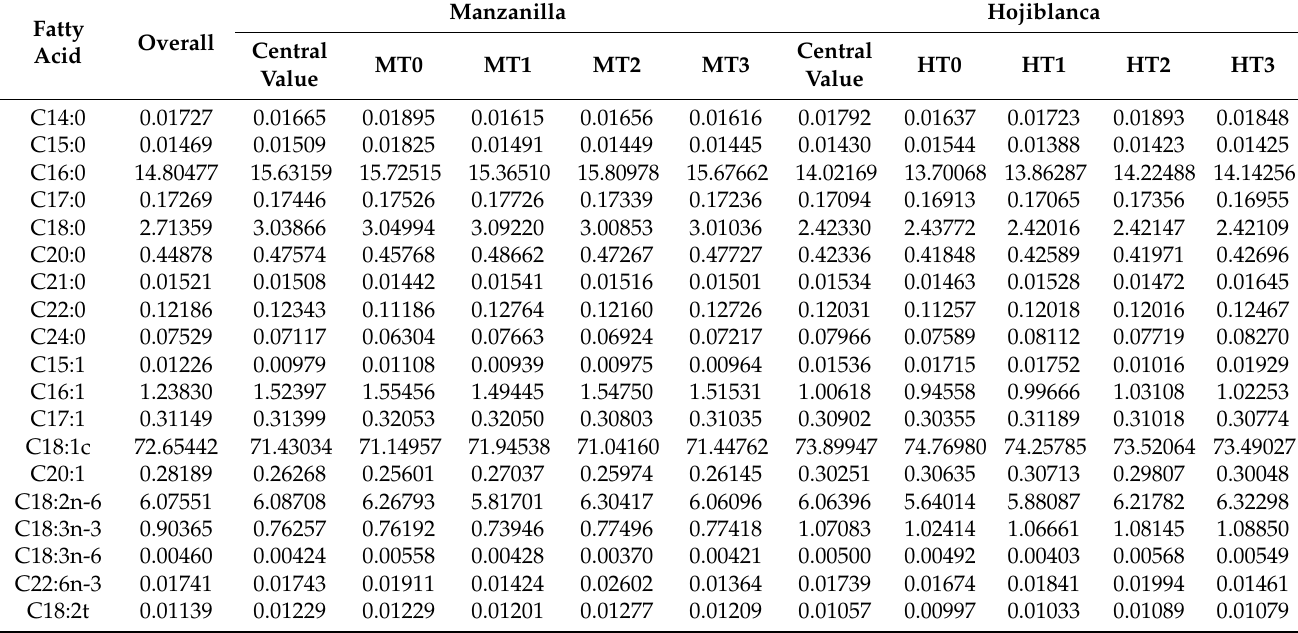
Table 3. Overall (estimated from the complete set of fatty acid percentages) geometric means as well as geometric means of cultivar and processing phase